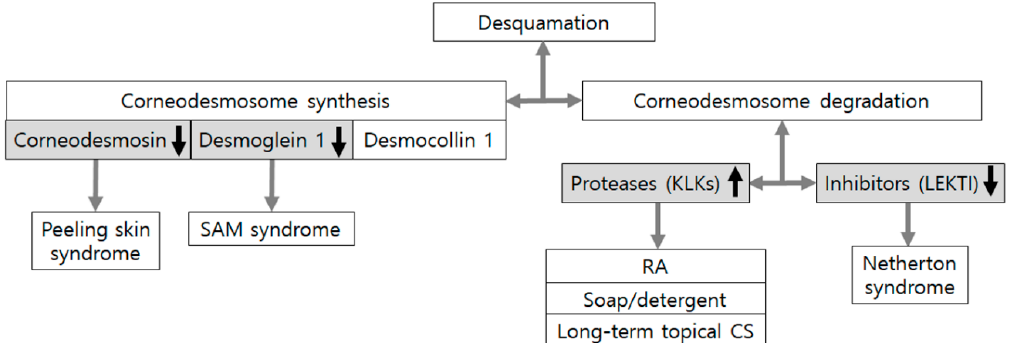
Figure 4. Corneodesmosome defects in skin conditions associated with epidermal barrier dysfunction. Desquamation is determined by de novo synthesis and degradation of corneodesmosomal proteins. Mutations in GDSN encoding corneodesmosin and DSG1 encoding desmoglein 1 can cause an inflammatory type of peeling skin syndrome and SAM syndrome (severe skin dermatitis, multiple allergies, and metabolic wasting), which is another inflammatory type of peeling skin syndrome, respectively. Degradation of corneodesmosomal proteins depends on the sum of activities from proteases, including kallikrein ‐ related peptidases (KLKs) and protease inhibitors including lymphoepithelial ‐ Kazal ‐ type 5 inhibitor (LEKTI). Experimental conditions, such as retinoic acid (RA) application, soap and detergent washing, and long ‐ term corticosteroid (CS) application, could also accelerate desquamation mainly by increased production of KLKs.